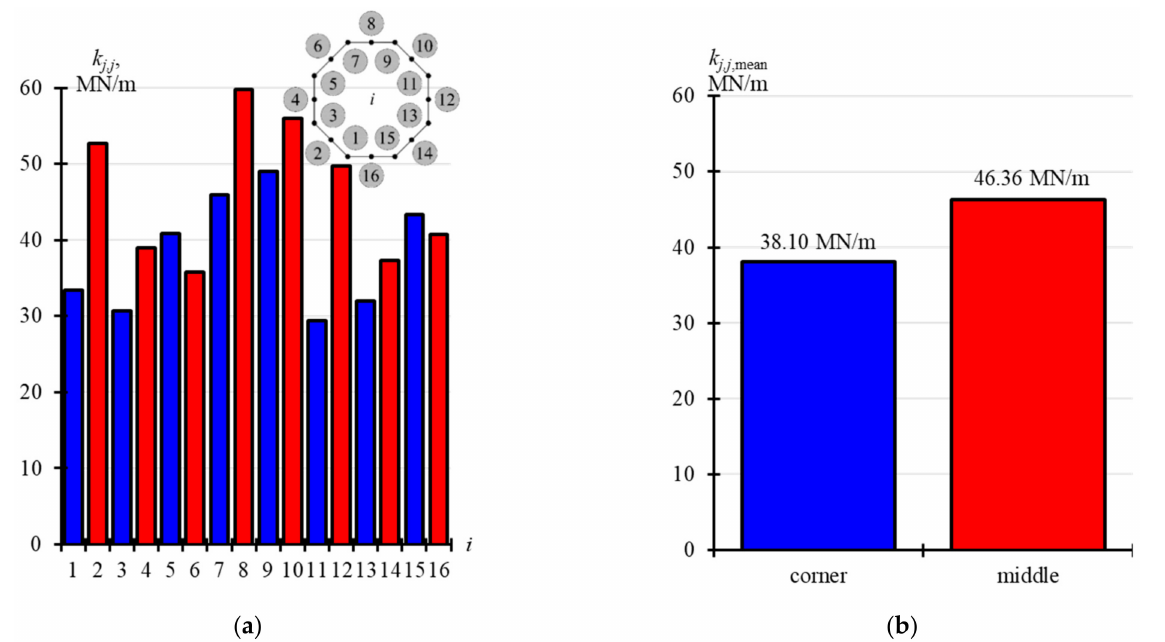
Figure 11. Results from in-situ tests for stiffness k j,j : ( a ) stiffness determined for n = 16 supports; ( b ) mean stiffness values corresponding to points in the slab corners (corner) and at the mid-point of the slab side